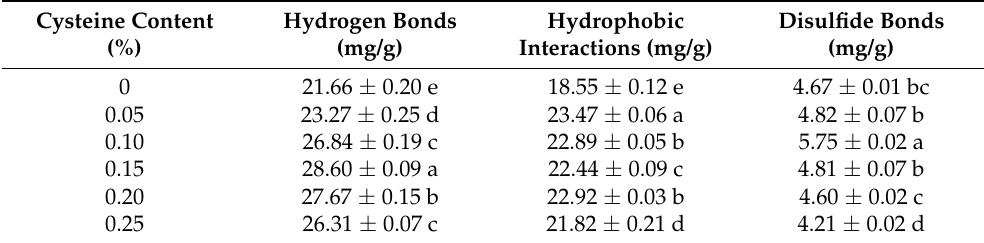
Table 3. Changes in protein solubility of the extrudates with the different addition of cysteine induced by different extracting